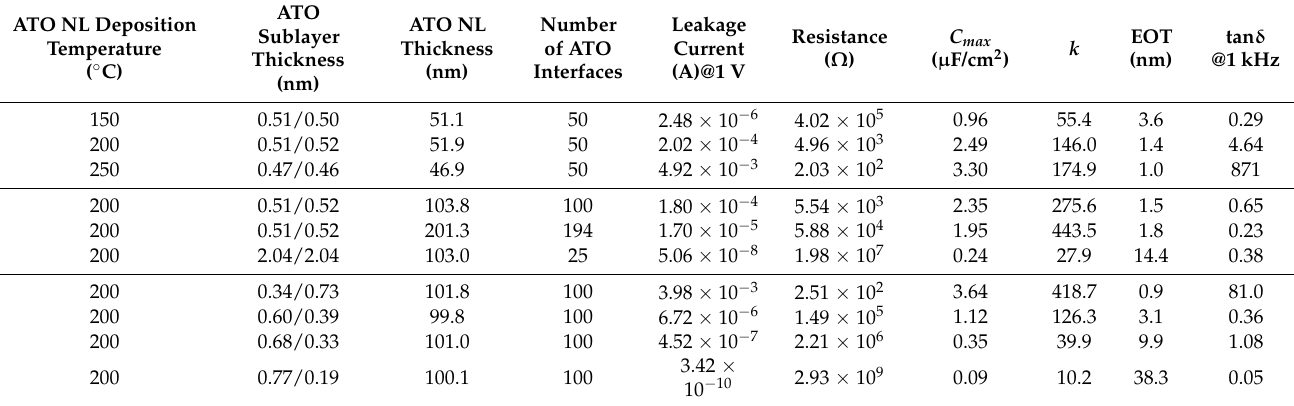
Table 1. Summary of the electrical properties of the Si/Ti/Pt/ATO NL/Ti/Au